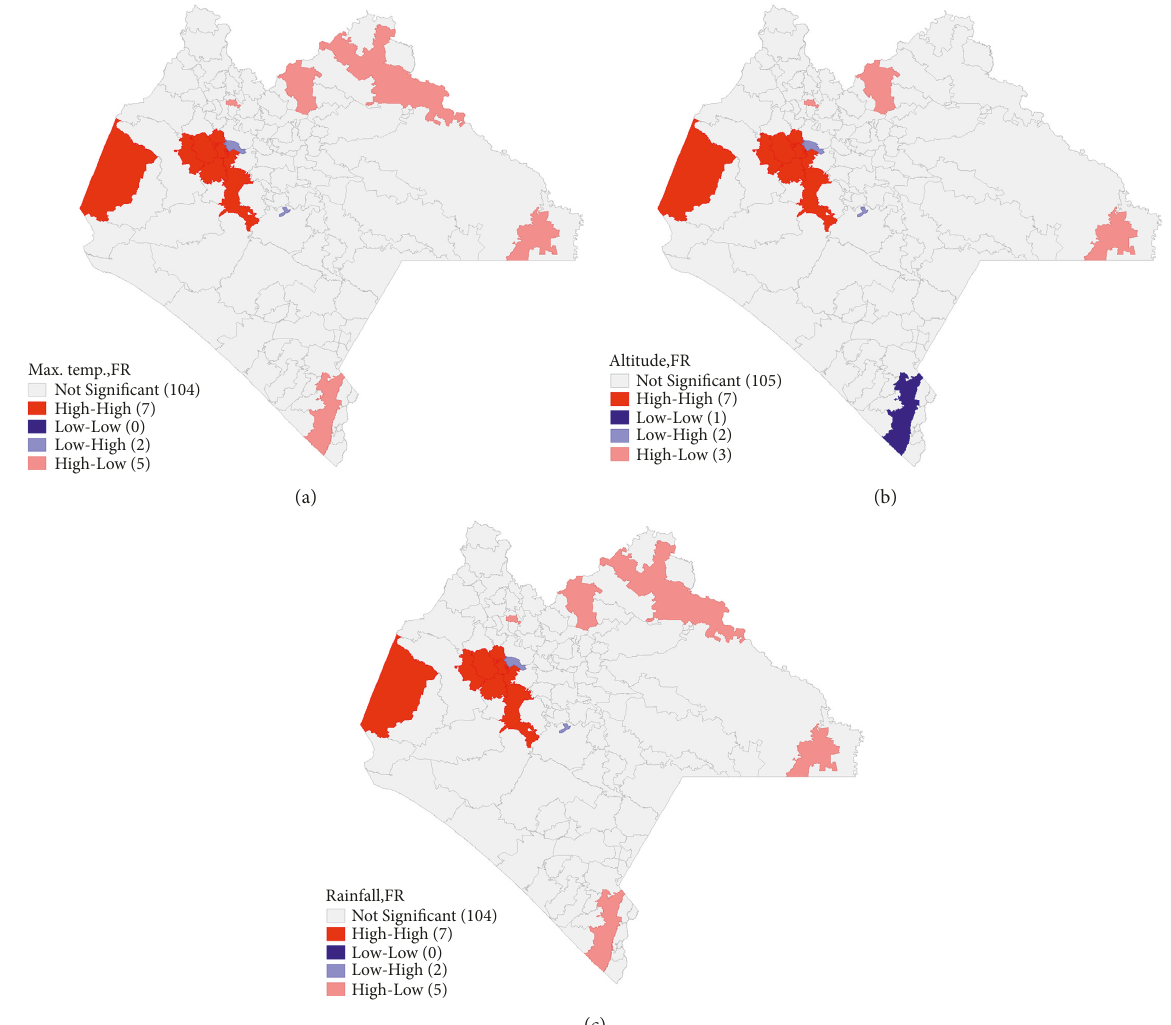
Figure 9: Significant spatial clustering of bivariate LISA for each of the significant variables in the spatial model and rate of confirmed dengue cases. Clusters of risk are